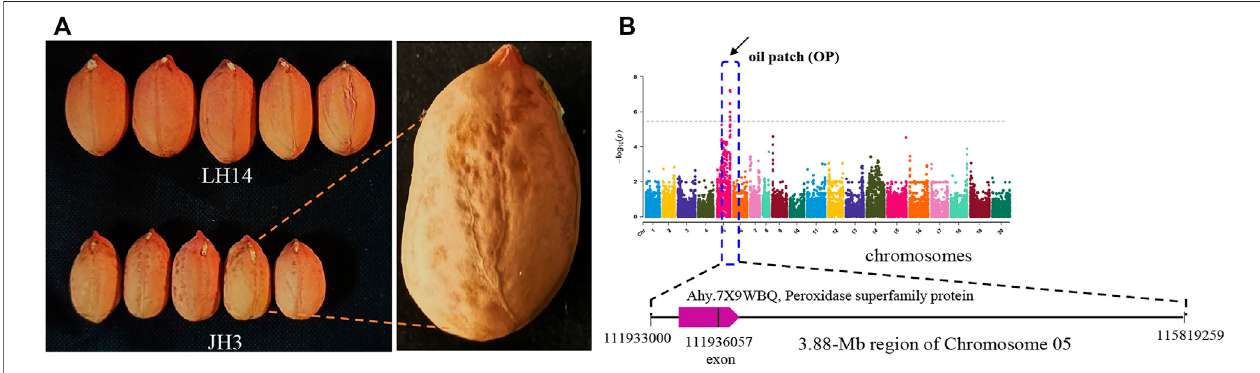
FIGURE 5 | GWAS signals for oil patch (spots) of peanut. (A) Peanut cultivars without an oil patch (LH14) and with an oil patch (JH3). (B) Manhattan plot. The characteristic analysis for one gene encoding peroxidase superfamily protein is shown